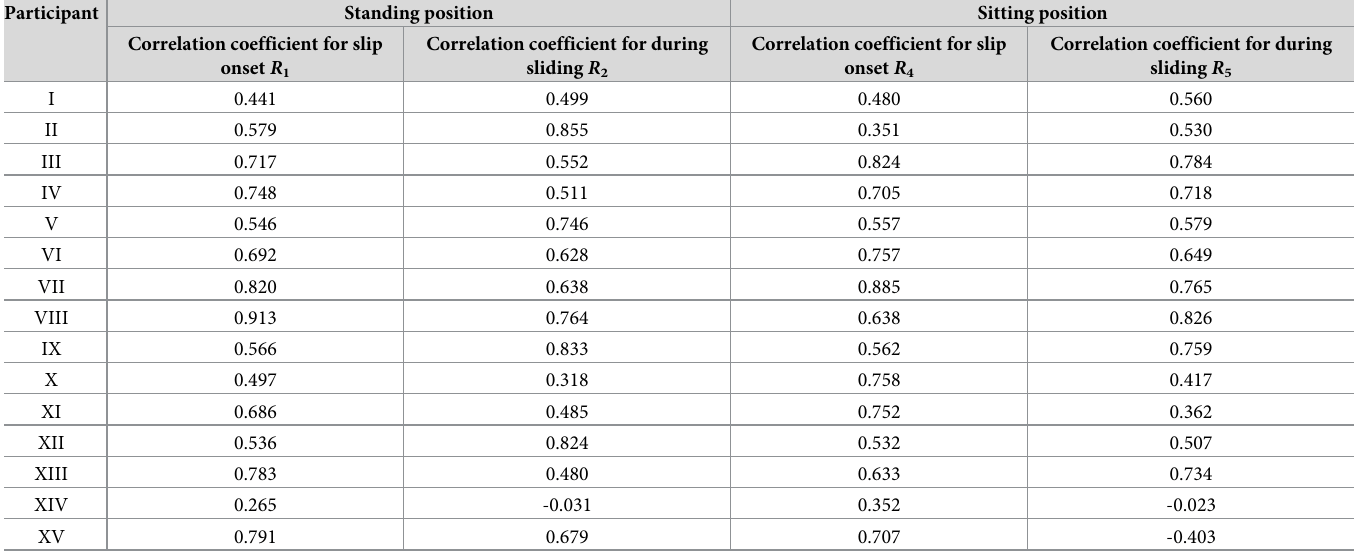
Table 6. Correlation coefficients for each participant before averaging.